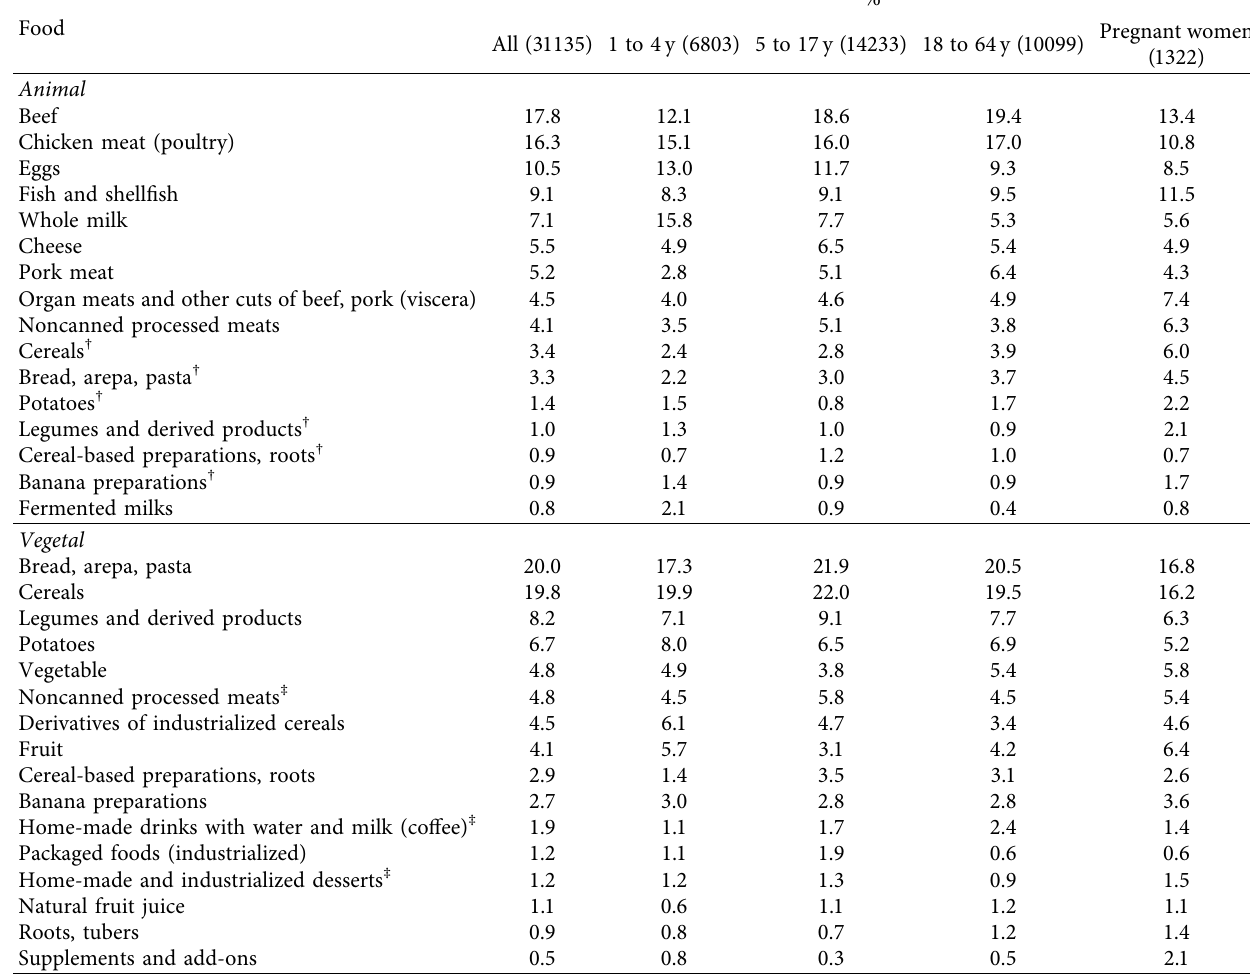
Table 4: Relative contribution (%) ∗ of the main sources to the total animal and vegetable protein in the Colombian population (aged from 1 to 64 years) (National Survey of Nutritional Situation in Colombia